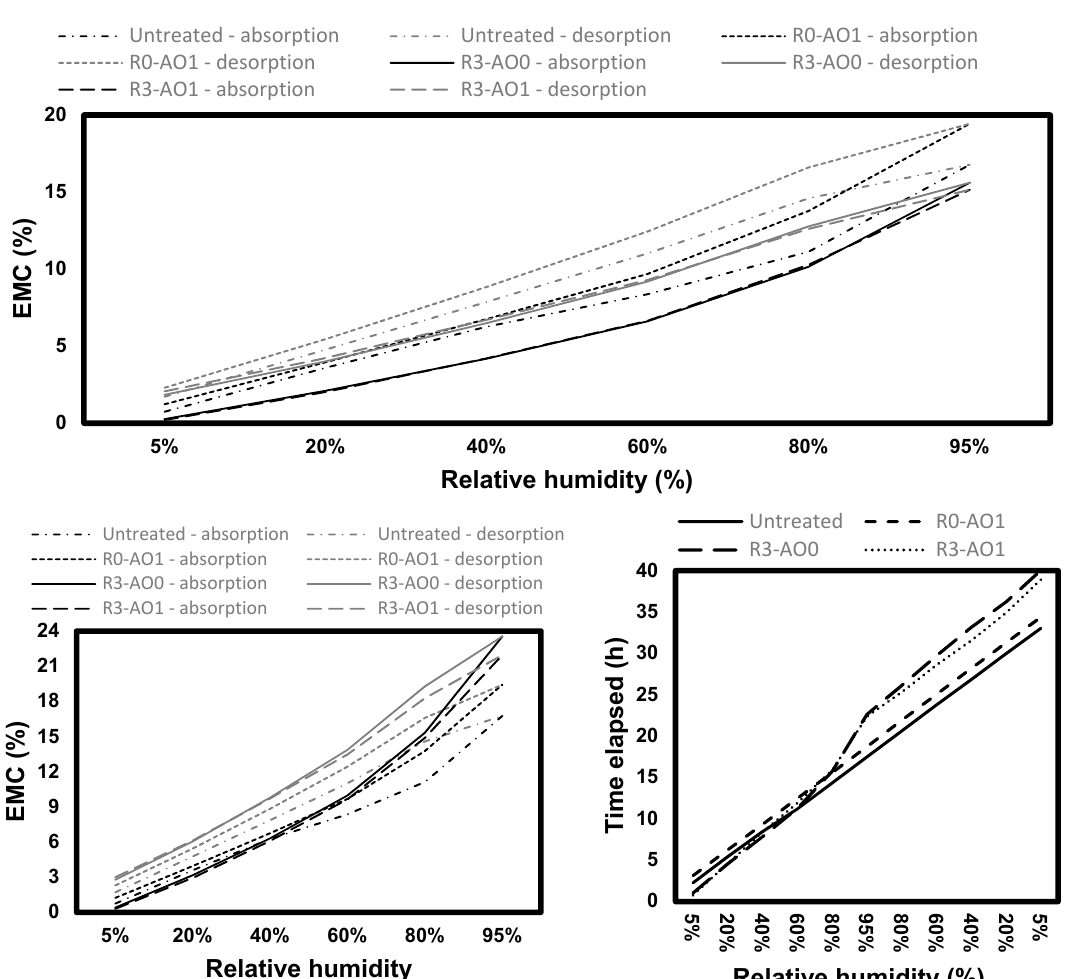
Figure 7. Equilibrium moisture content (EMC) of the samples before ( top ) and after removing the mass of the coatings ( left ), and time elapsed after reaching the equilibrium ( right ) at the different steps during the sorption isotherms in white spruce.